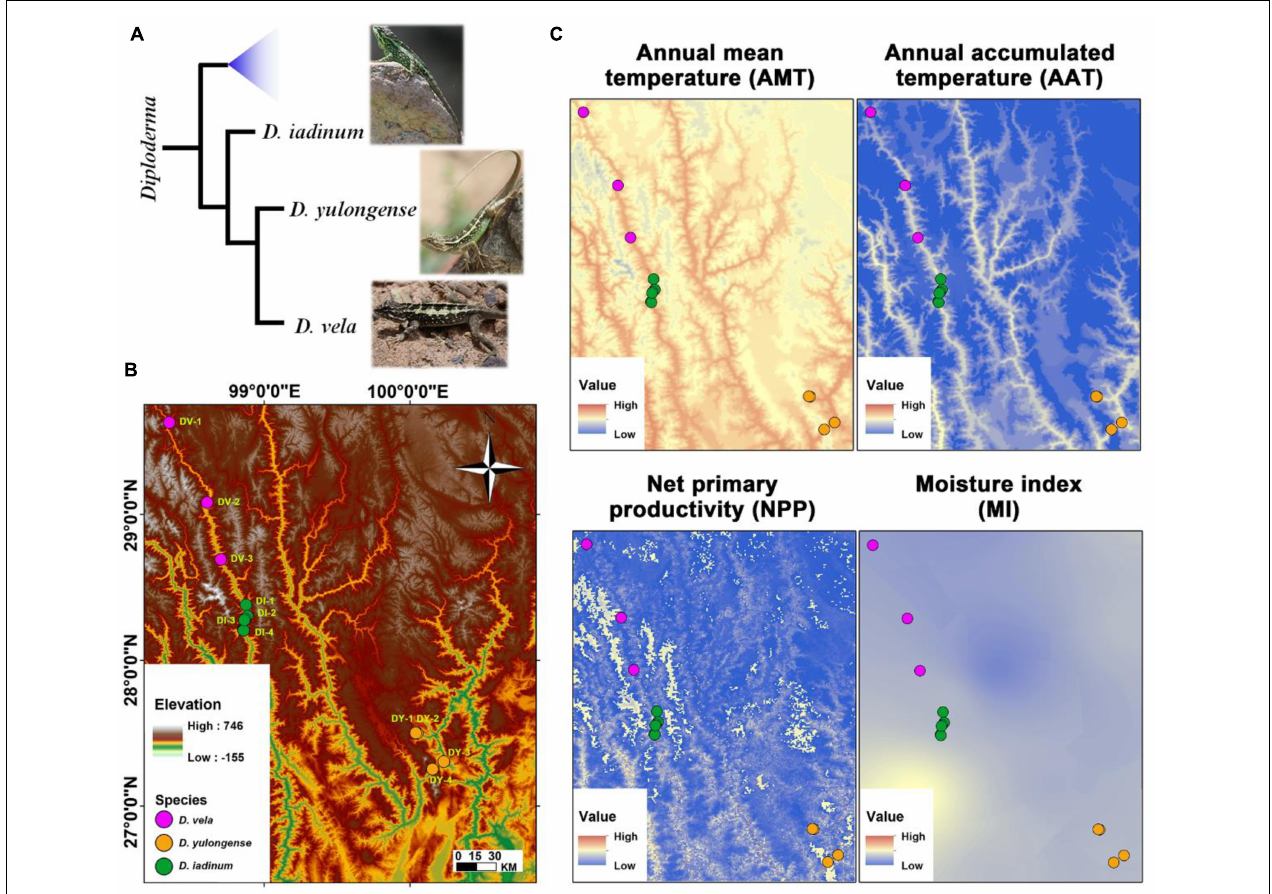
FIGURE 1 | Animal phylogeny, study area, and significant climatic factors. (A) The phylogenic relationships of Diploderma species ( D. iadinum , D. yulongense , and D. vela ) (Wang et al., 2020). (B) Study area and sample collection sites. (C) Maps illustrating the major climatic factors. The white area in the map of net primary productivity (NPP) denotes that data are